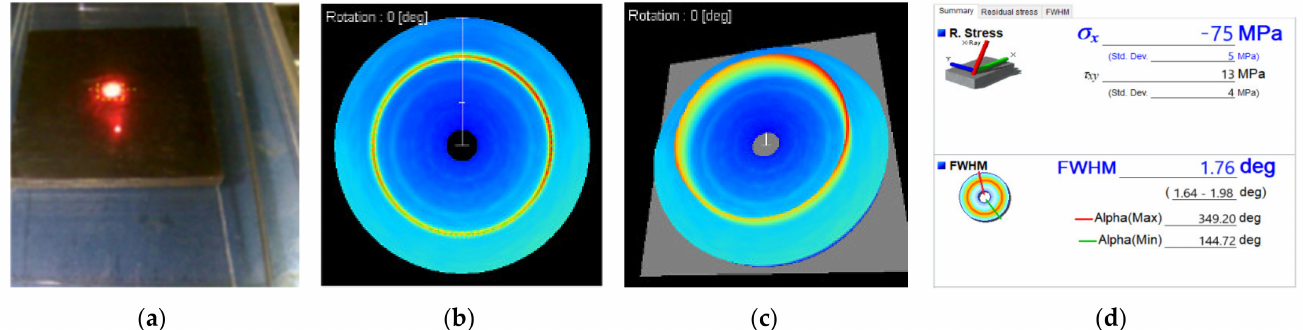
Figure 11. Surface residual stress test diagram and test results of Ti-6Al-4V before polishing. ( a ) Test diagram; ( b ) Debye ring(2D); ( c ) Debye ring(3D); ( d ) surface residual